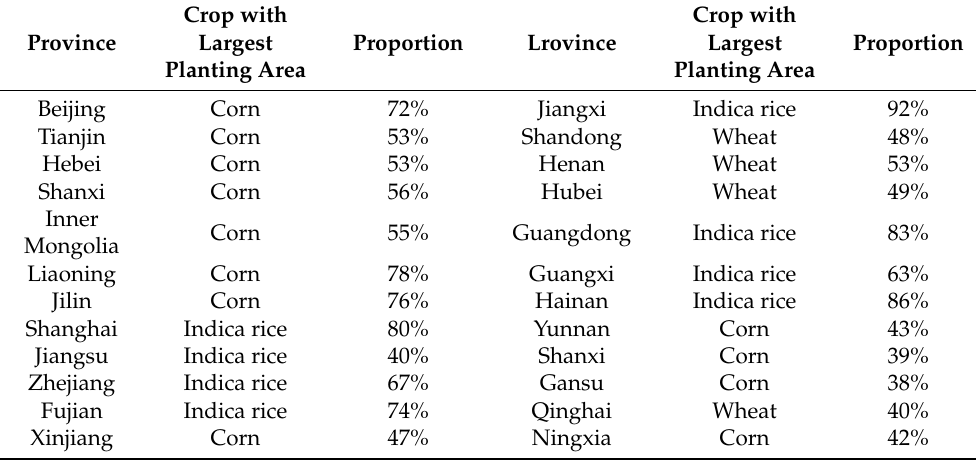
Table 2. The crop with the largest planting area and its planting proportion in each region.